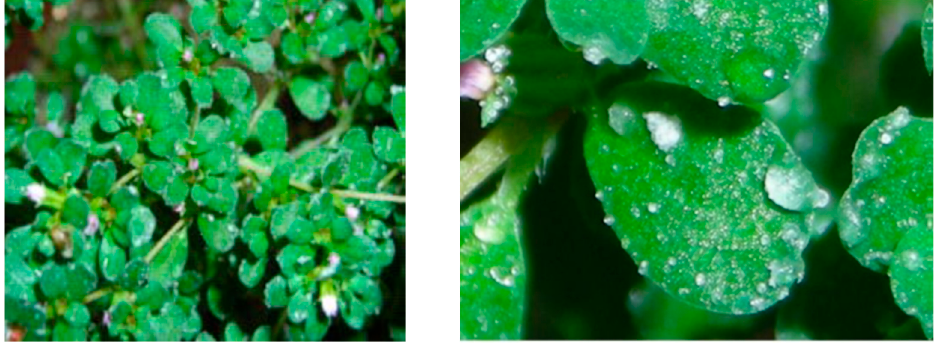
Figure 3. Salt crystals on surface leaves of F. pulverulenta .